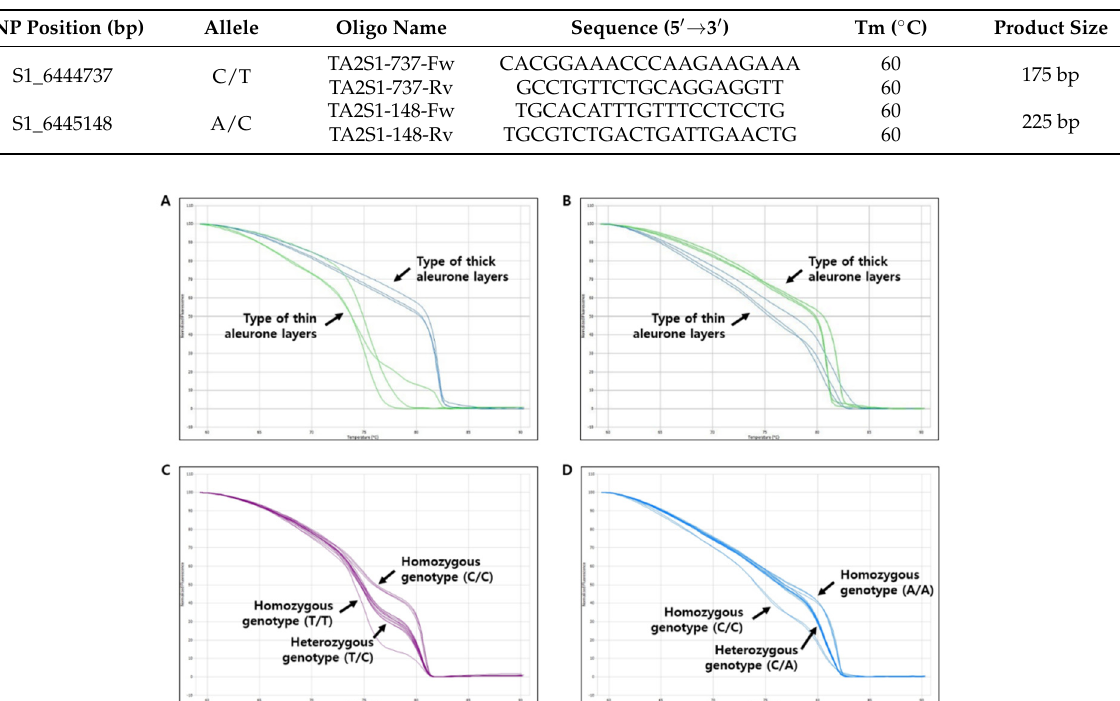
Table 4. Information of the two SNP markers for selecting the seed coat and aleurone layers as HRM PCR markers.